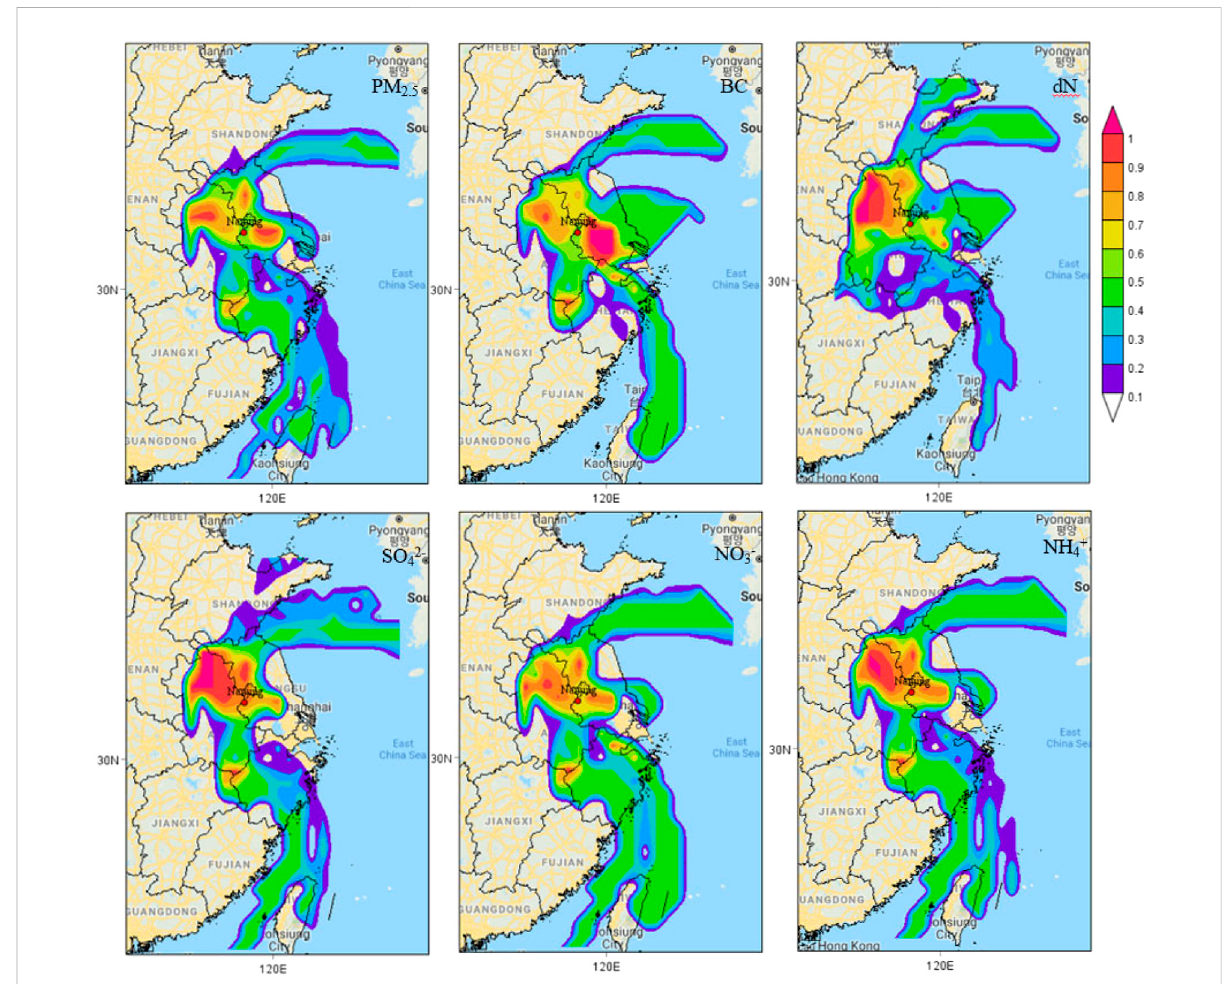
FIGURE 7 The PSCF analysis of major pollutants with forward trajectory during the